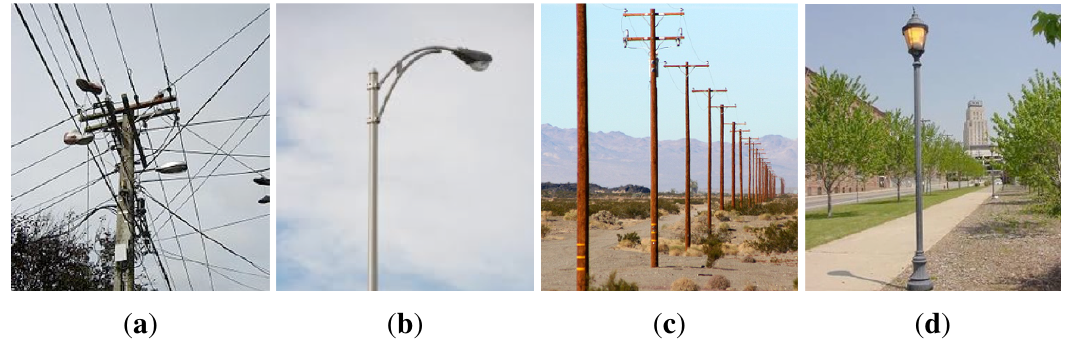
Figure 42. Sophisticated ( a ), curved ( b ), perceptual aliased real world power line ( c ) and street light pole ( d )